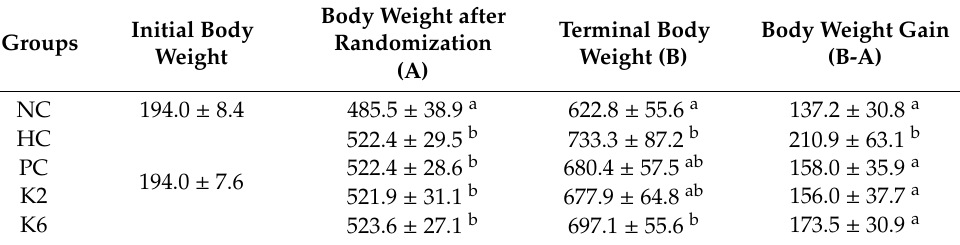
Table 2. Body weight of rats in each groups